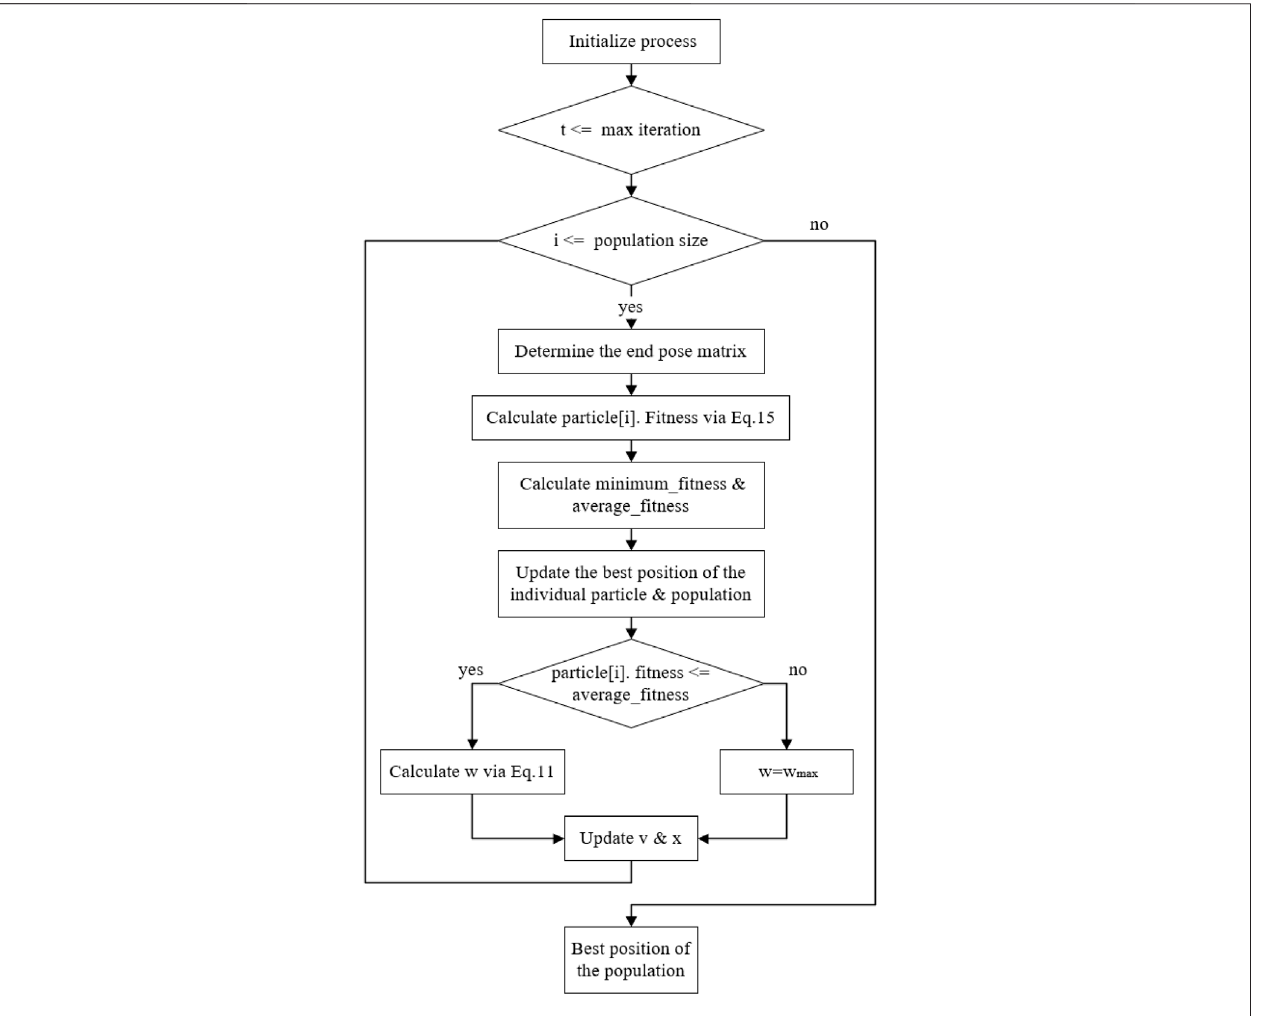
FIGURE 4 | Main loop.